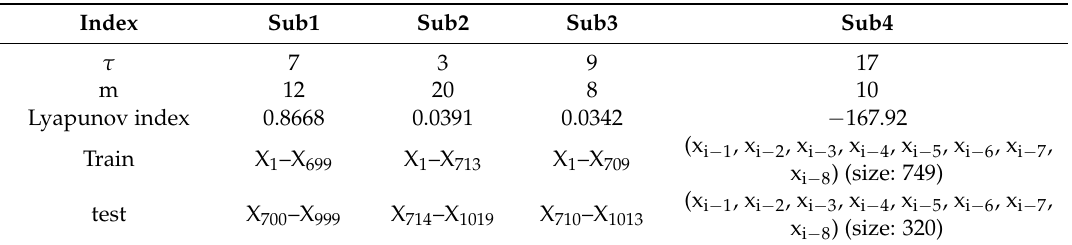
Table A8. The parameters of each subsequence decomposed by EMD of the Hubei carbon price.